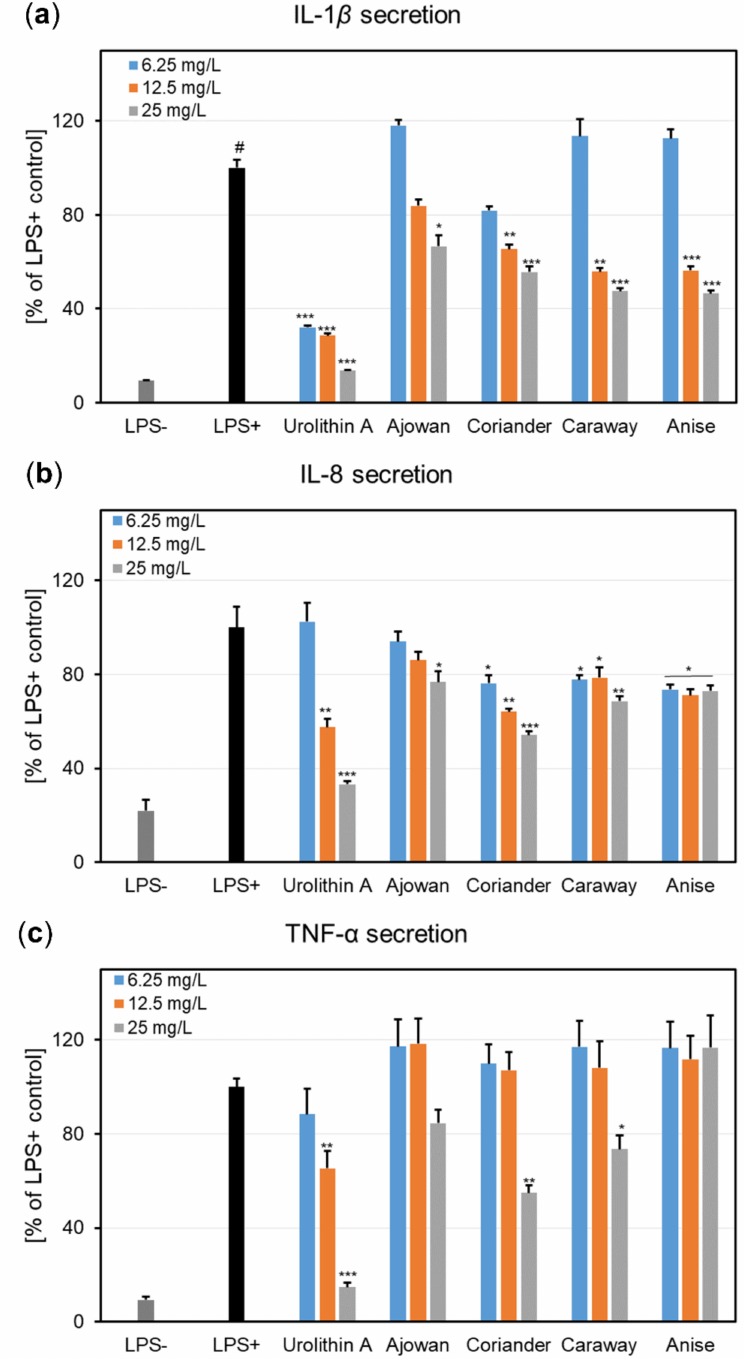
Figure 2. Effects of essential oils of ajowan, coriander, caraway, and anise (6.25–25 mg/L), and urolithin A (12.5, 25 and 50 µ M) on IL-1 β ( a ), IL-8 ( b ), and TNF- α ( c ) secretion in LPS-stimulated neutrophils. Results were expressed as mean ± SEM of three separate experiments performed with cells isolated from four independent donors. Statistical significance: # p < 0.001 compared to the non-stimulated control (LPS-); * p < 0.05, ** p < 0.01, *** p < 0.001 compared to the stimulated control